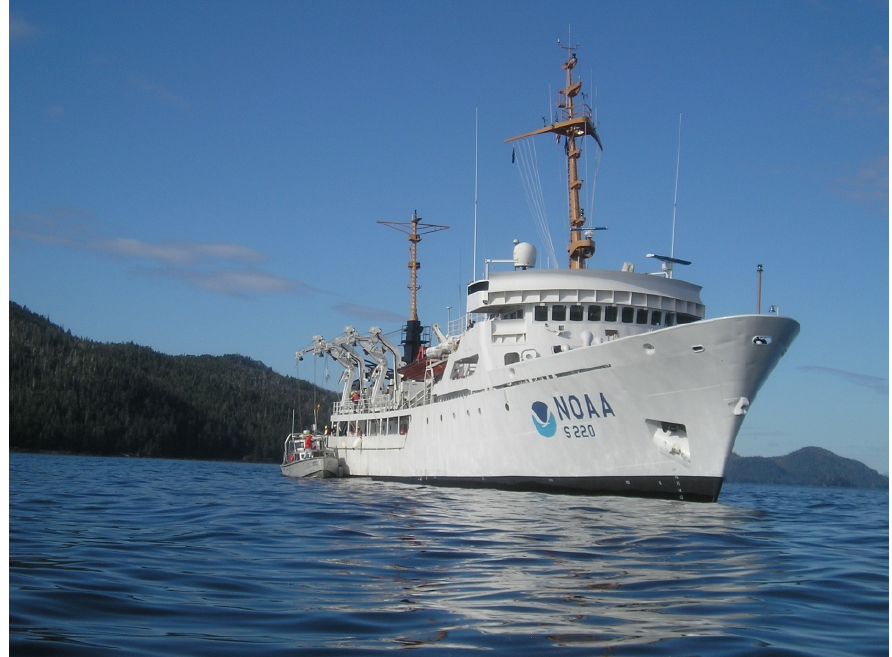
Figure 2. Image of NOAA Ship Fairweather , courtesy of NOAA.